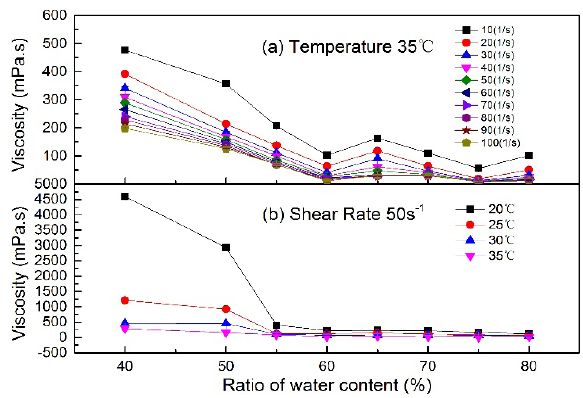
Figure 10: Dependencies of viscosity on the water content in the system of polymer. concentration (1053 mg/L) and (a) temperature (35 ) (b) shear rate (50s -1 ). ℃ Table 2: Summary of the phase transition points fluids produced containing different polymer concentrations. Polymer Concentration, Phase transition mg/L